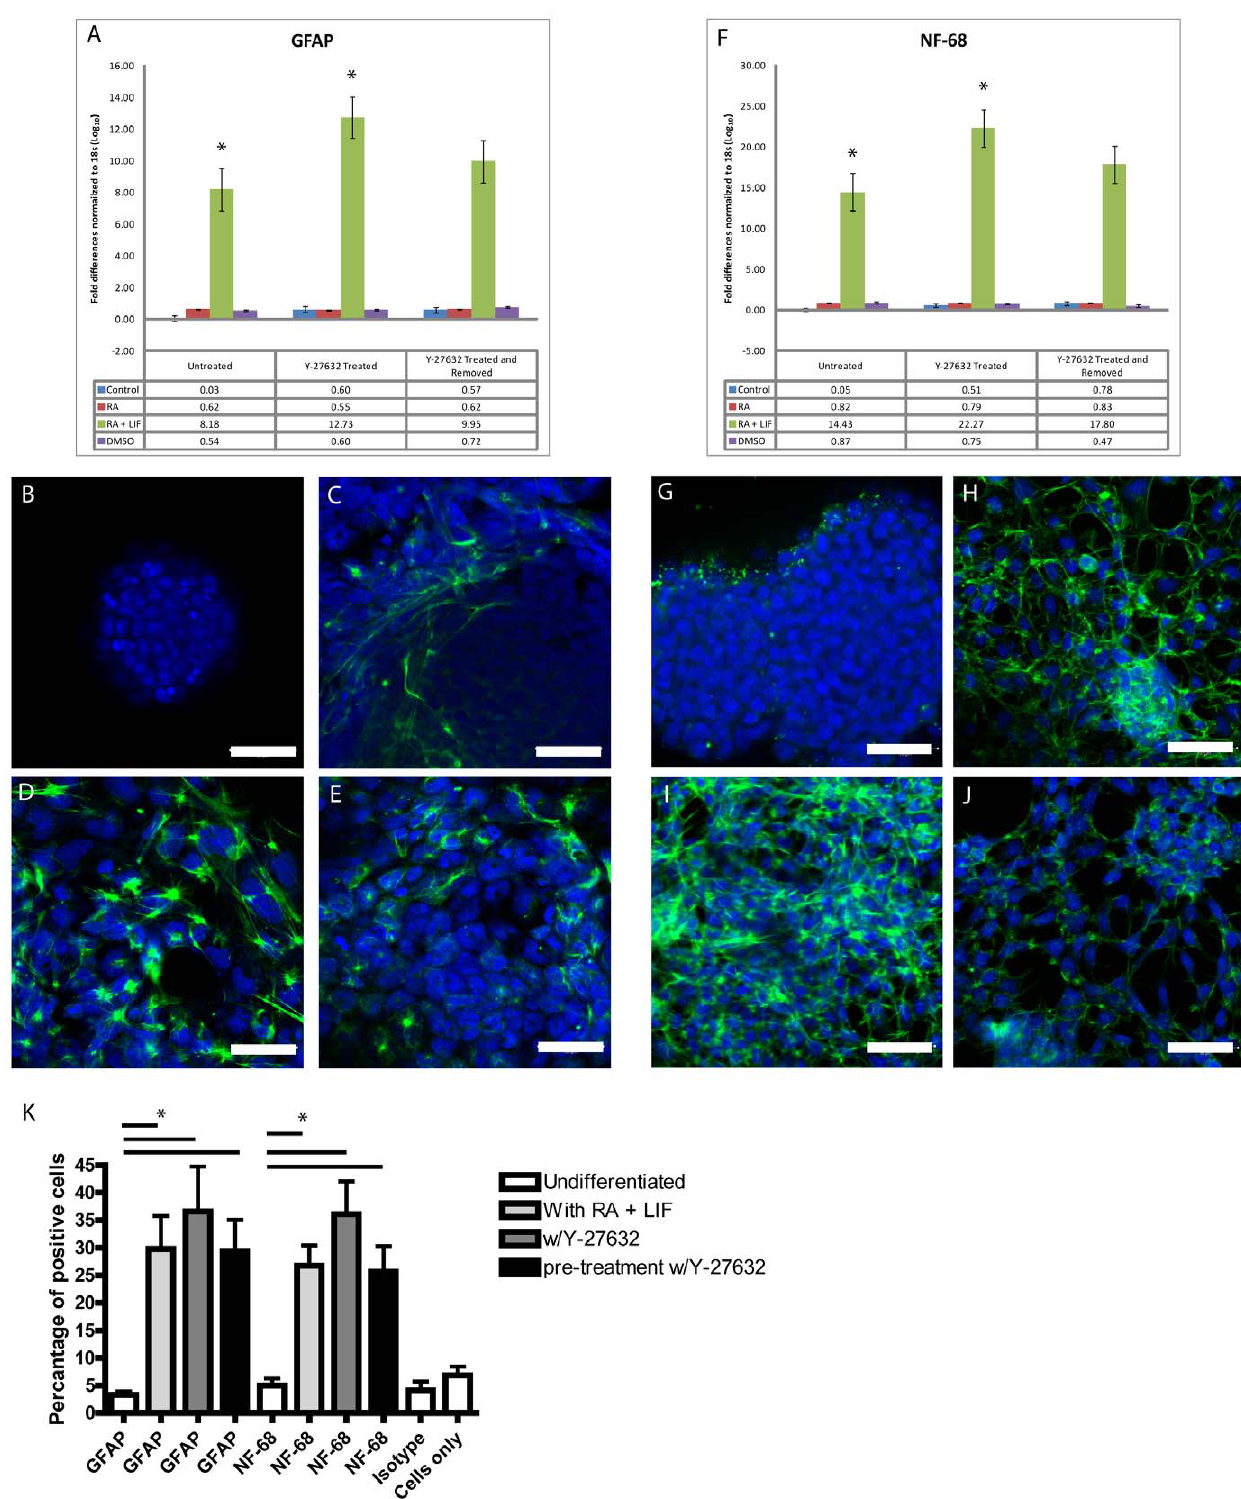
Figure 3. Y-27632 enhances the differentiation of P19 cells into ectoderm. P19 cell aggregates were treated with RA + LIF to induced neural- ectoderm differentiation. Total mRNA was collected, converted to cDNA and used in a PCR to examine GFAP expression, a marker of ectodermal derived neural cell types (A). GFAP levels increased with RA + LIF treatment in the presence or absence of Y-27632. Increased GFAP expression was also detected in the DMSO treated groups supplemented with Y-27632. Immunofluorescent detection of GFAP in undifferentiated (B) RA + LIF (C) RA + LIF and Y-27632 (D) or RA + LIF with Y-27632 pre-treated cells (E). qPCR with NF-68 primers showed an increase in expression in cells exposed to Y-27632 during differentiation (F). Immunofluorescent detection of NF-68 in undifferentiated cells or those exposed to the following: (G) RA + LIF (H) RA + LIF and Y-27632 (I) or RA + LIF with Y-27632 pre-treatment (J). FACS analysis demonstrates increased numbers of GFAP- (trend) and NF-68-positive cells